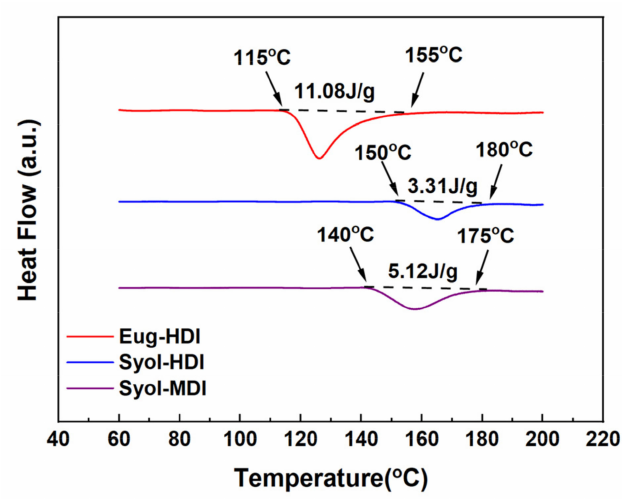
Figure 8. DSC curves of